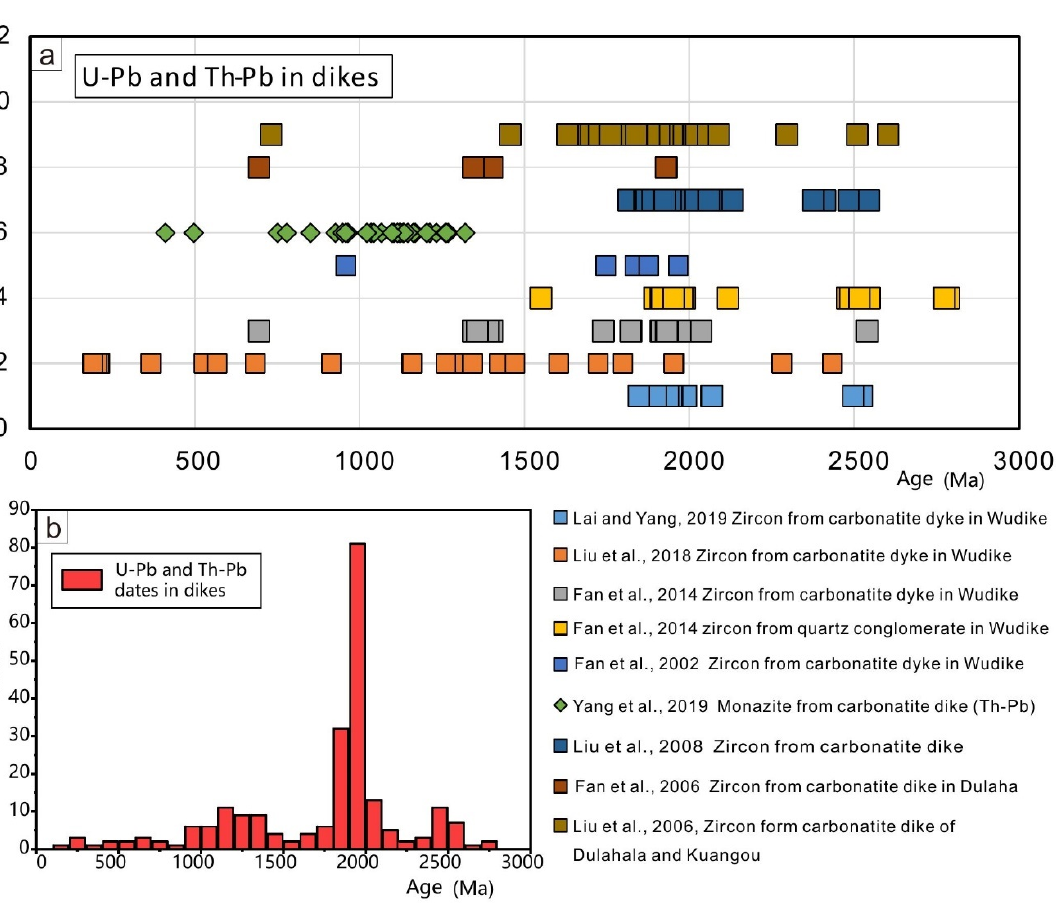
Figure 12. Age distribution characteristics of U–Pb and Th–Pb in carbonatite. ( a ) Single age distribution characteristics corresponding to different studies. ( b ) Stack histograms of all ages. [1,3,37–42].